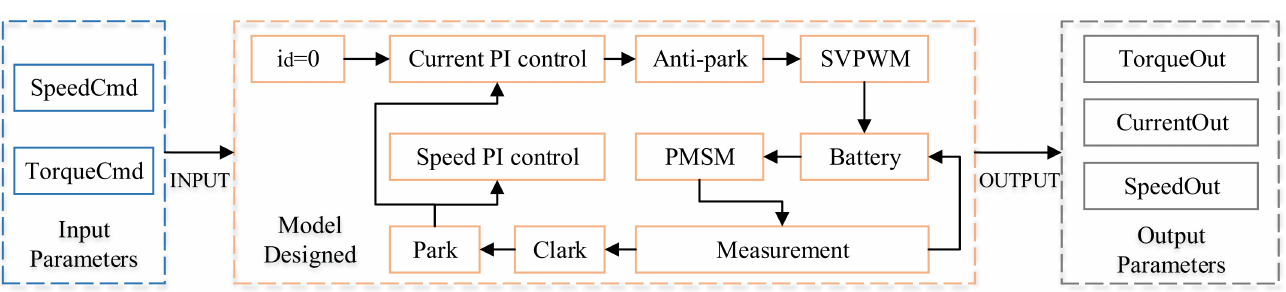
Figure 3. The PMSM model.